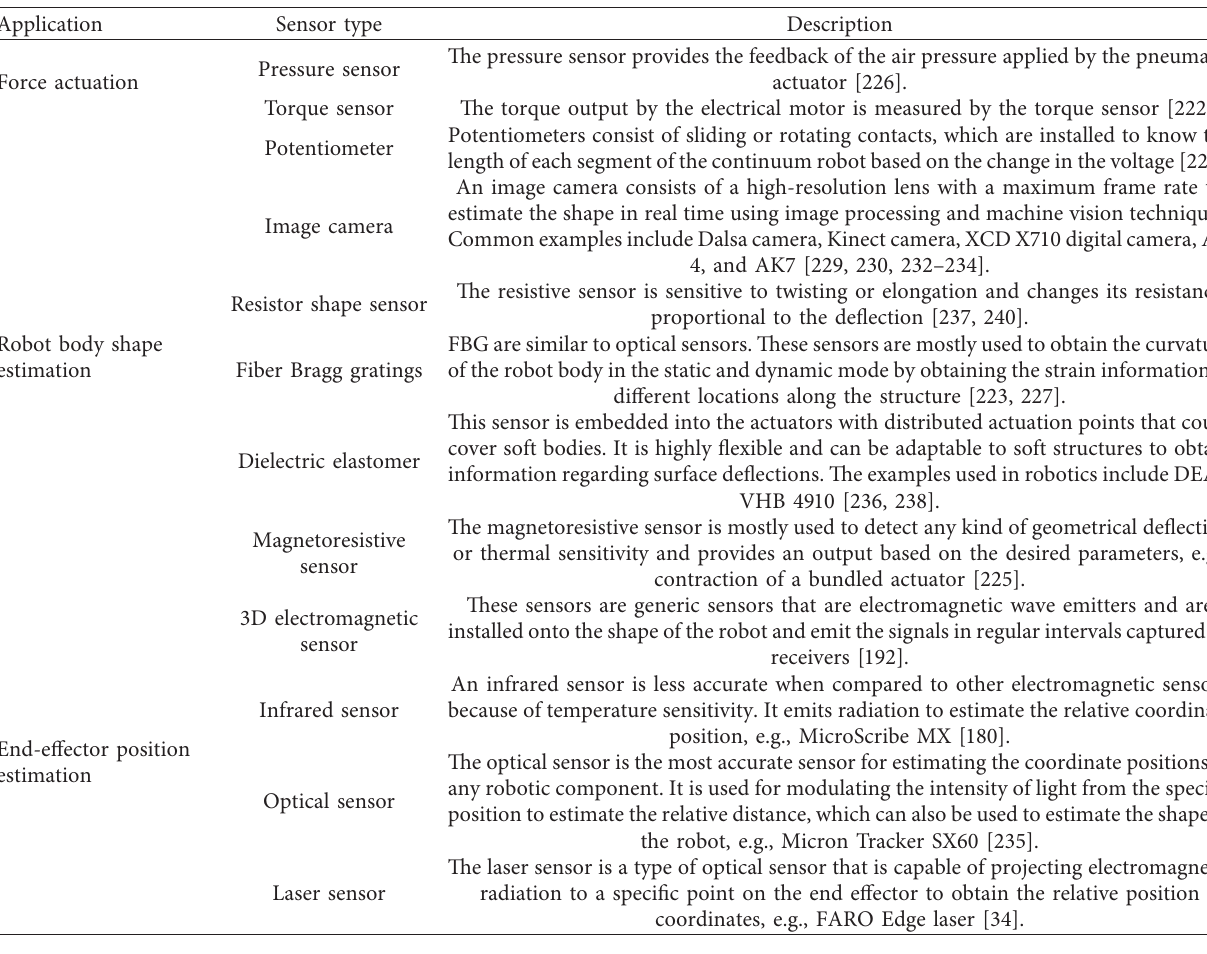
Table 9: Types of sensors and their